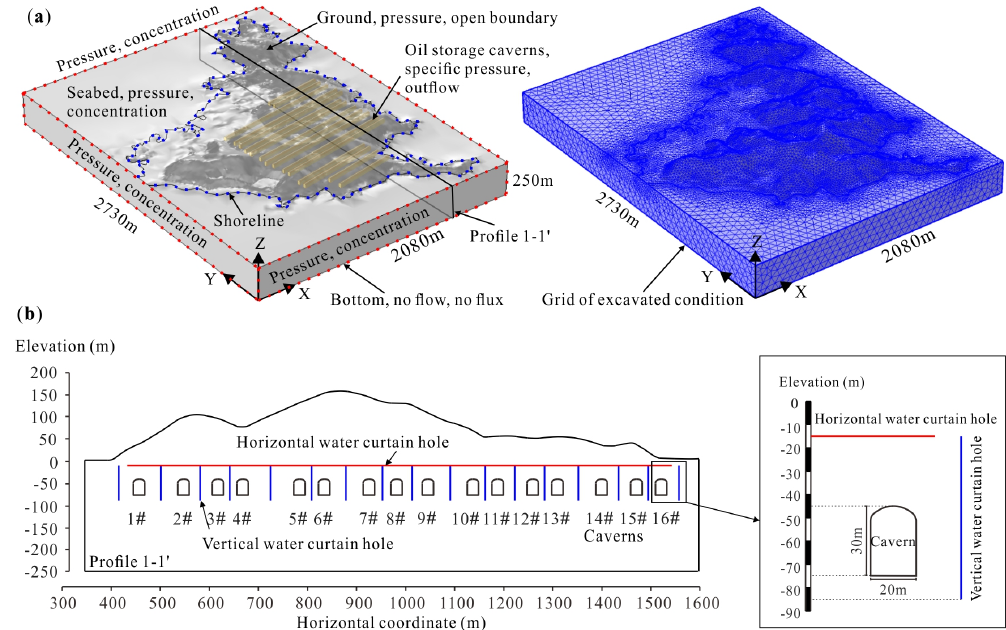
Figure 6. Numerical model: ( a ) three-dimensional numerical model; ( b ) numerical model profile. Table 1. The computational grid and the size resolution of the four models.